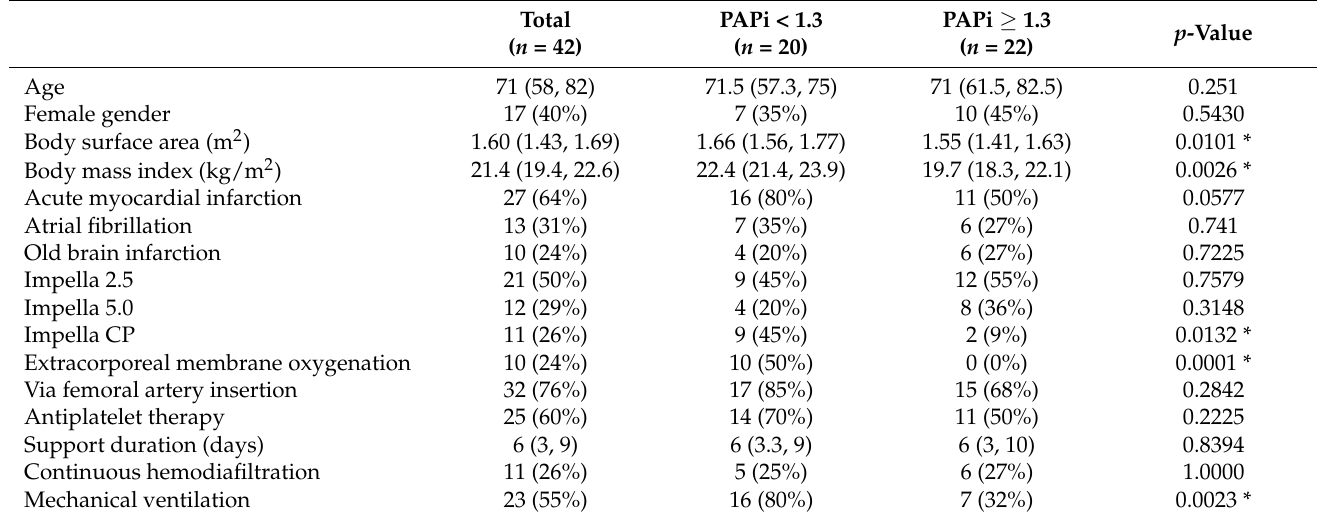
Table 1. Baseline demographic characteristics.